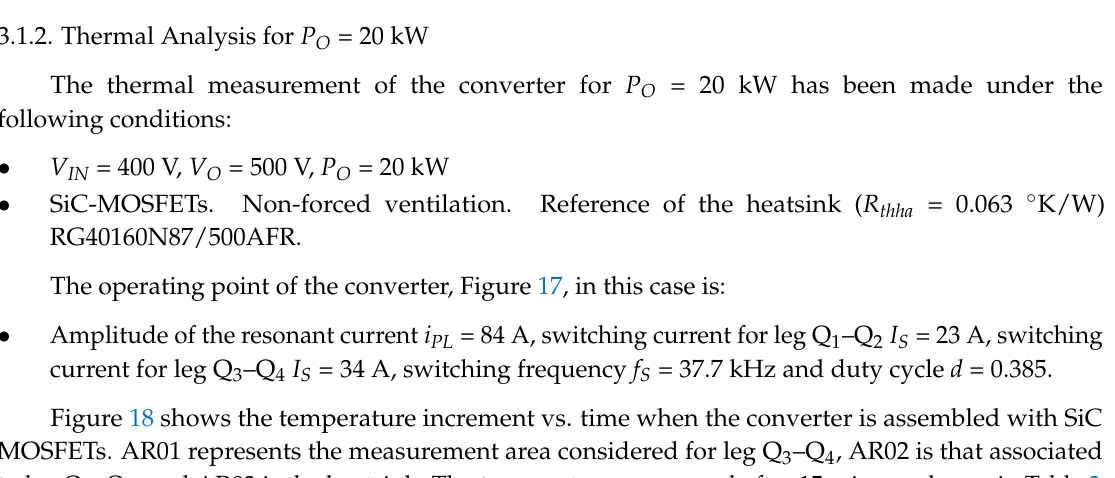
Table 2. Temperature Measurements for P O = 5 kW in SiC MOSFET and Si IGBT after 15 min. P O = 5 kW V IN = 300 V V O = 250 V Temperature T Q1–Q2 T Q3–Q4 T Heatsink IGBT 54.6 °C 45.3 °C 36.2 °C MOSFET 34 °C 31.8 °C 30.6 °C